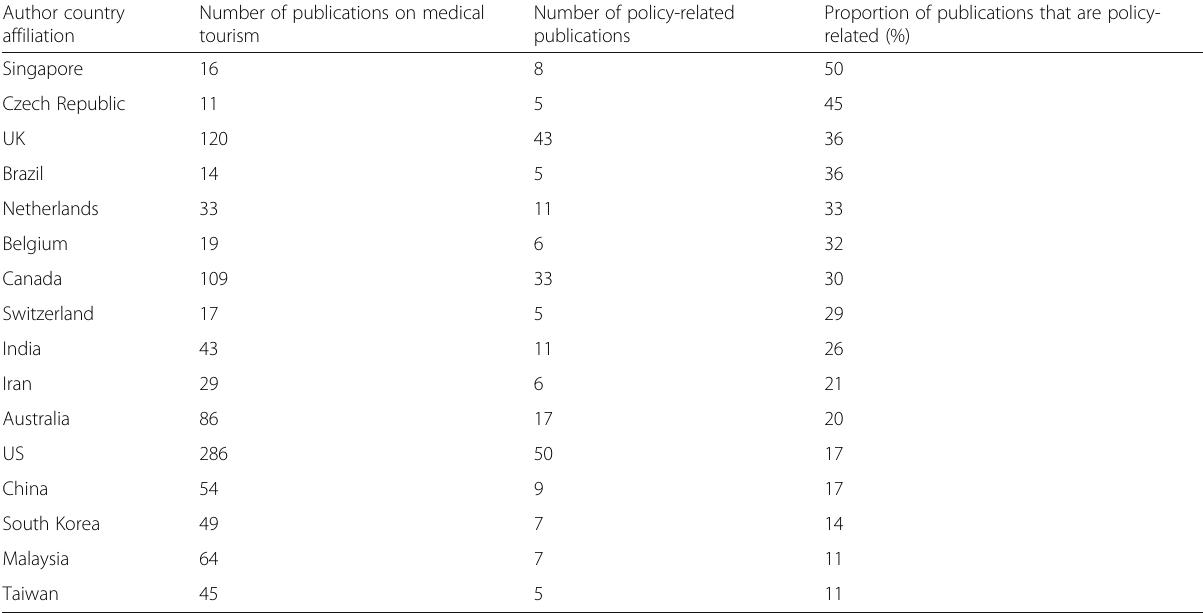
Table 2 Proportion of policy-related publications on medical tourism by authors in various countries (selected list of countries with ≥ 5 policy-related